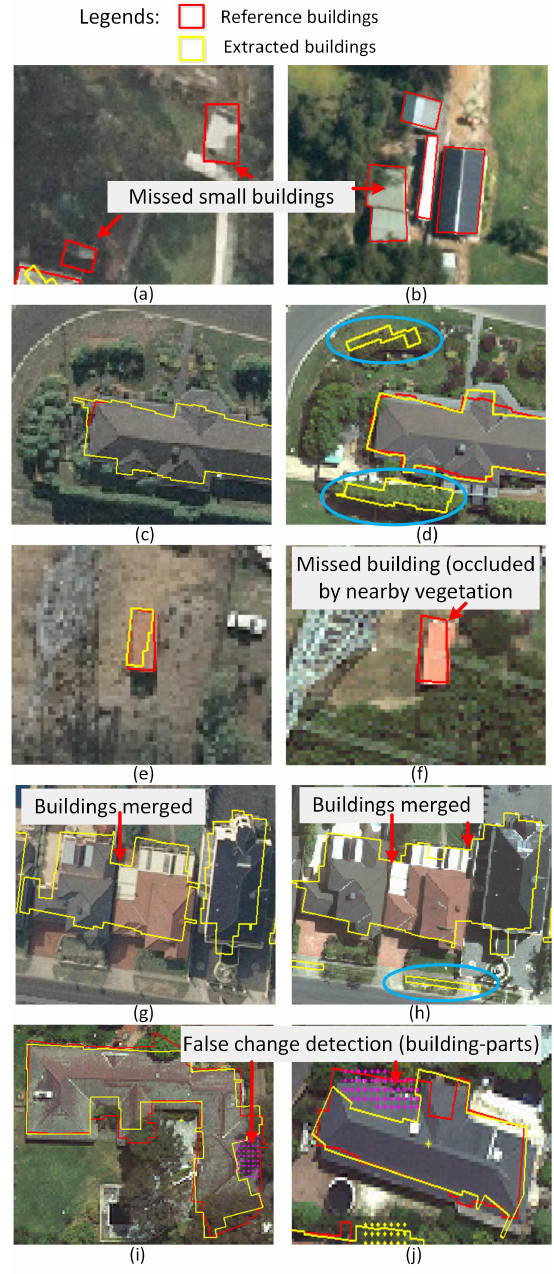
Figure 7. Examples of building detection from Figure 6. Left column: results from 2007 datasets and Right column: from 2012 datasets. ( a , b ) missing buildings, ( c ) correct elimination of trees, ( d ) dense vegetation detection, ( e ) correct building detection in 2007, but ( f ) missing in 2012, ( g , h ) under-segmentation errors, and ( i , j ) false change